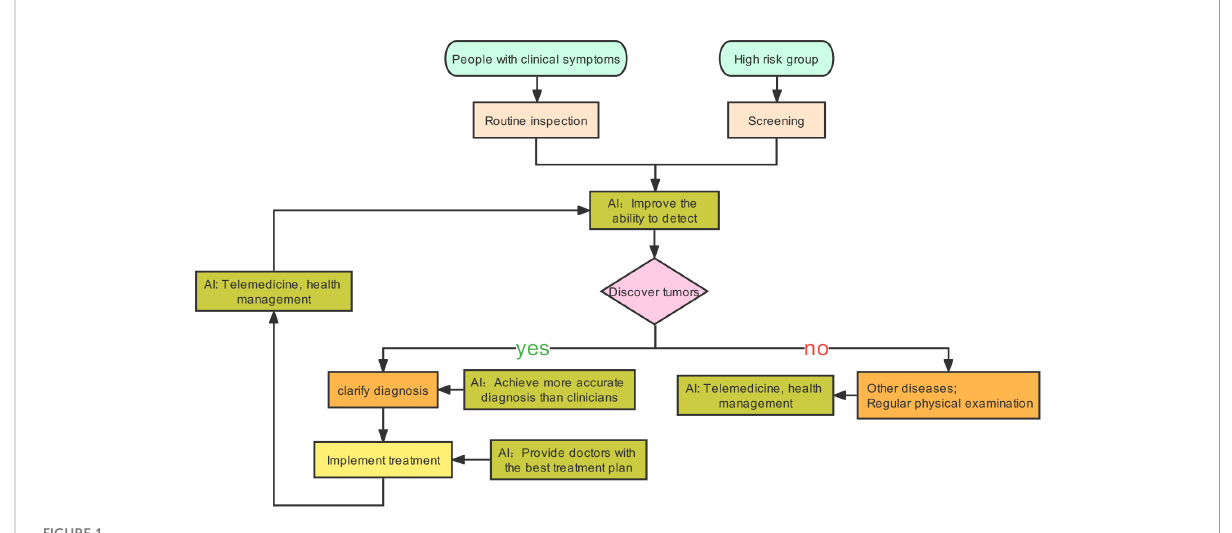
FIGURE 1 Possible changes caused by AI injection into clinical